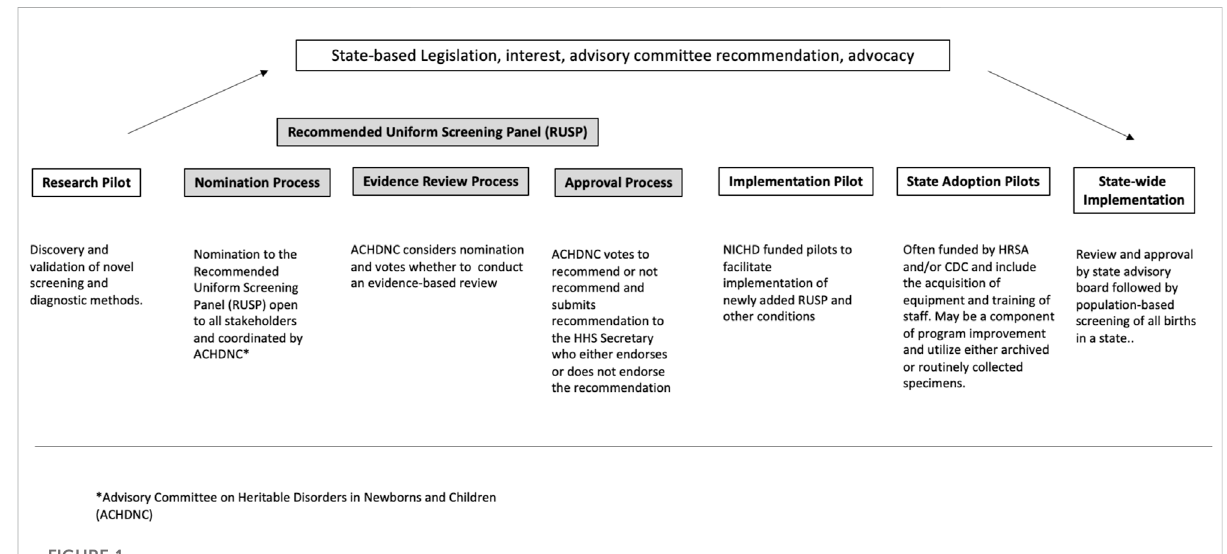
FIGURE 1 Pathway of candidate conditions (adapted from Brower et al.,